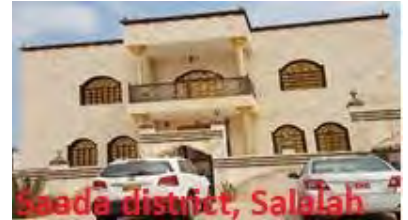
Figure 16. Fac¸ade’s photograph building location